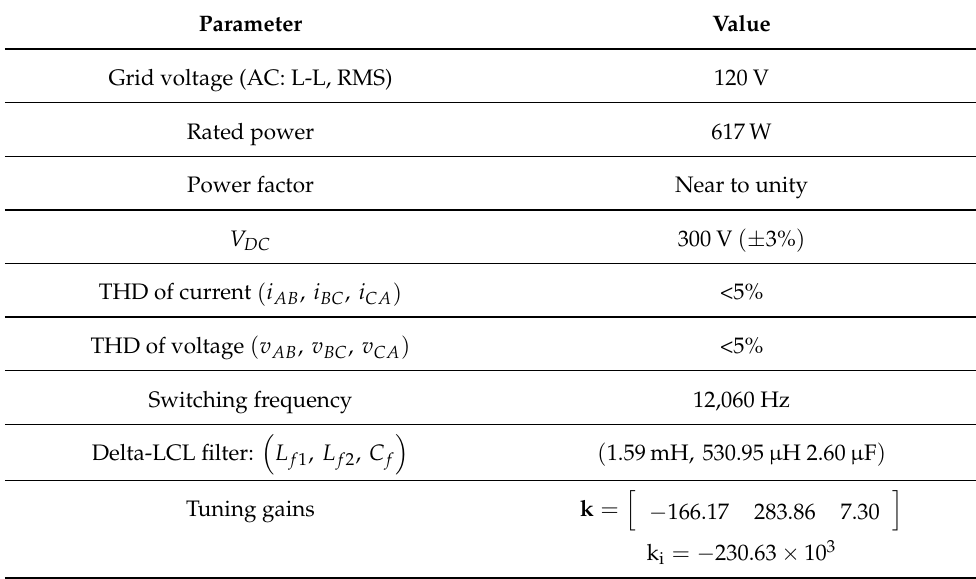
Table 6. LCL filter and grid-connected converter electrical parameters.